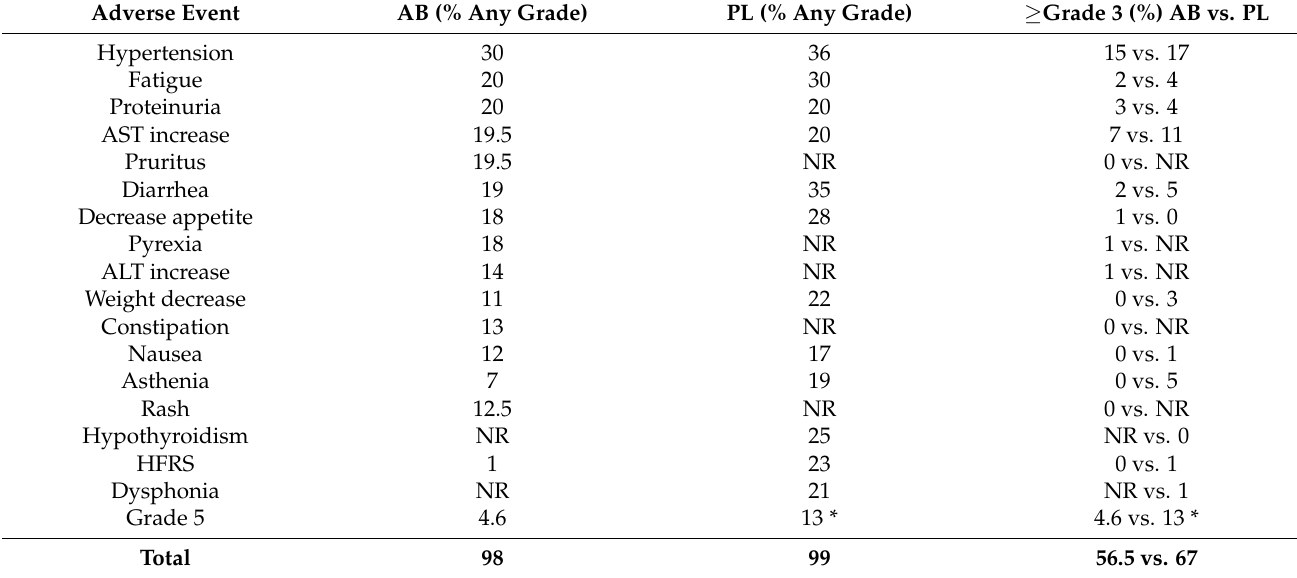
Table 6. Main AEs: Atezolizumab + Bevacizumab (AB) [12] vs. Pembrolizumab + Lenvatinib (PL) [69]. Adverse